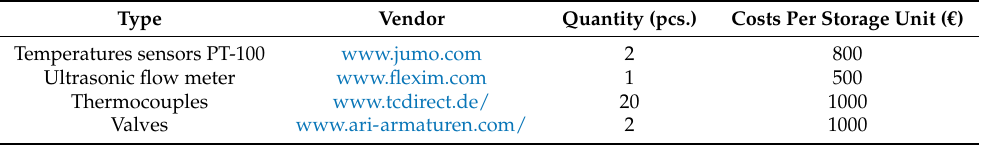
Table 3. Costs for valves and sensors for LHTS and concrete storage based on previous projects. Type Vendor Quantity